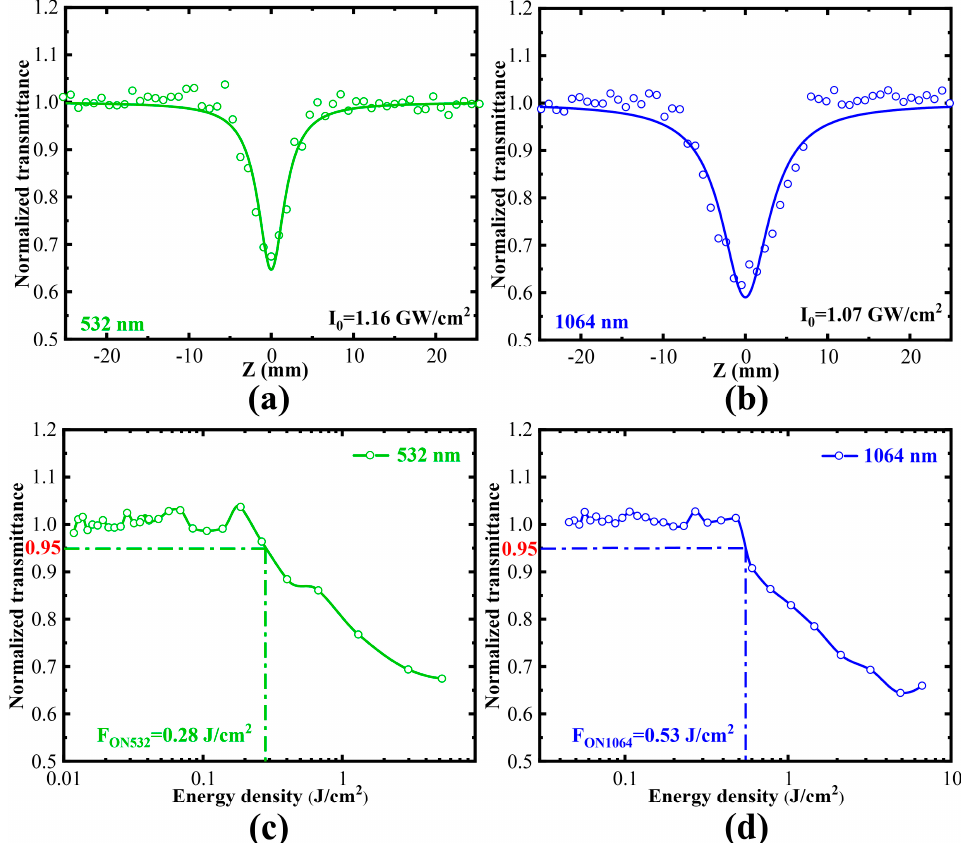
Figure 4. Nonlinear optical properties of siloxene nanosheet dispersions. ( a , b ) Z-scan results at 532 nm and 1064 nm; ( c , d ) Normalized transmittance and energy density curves at 532 nm and 1064 nm.